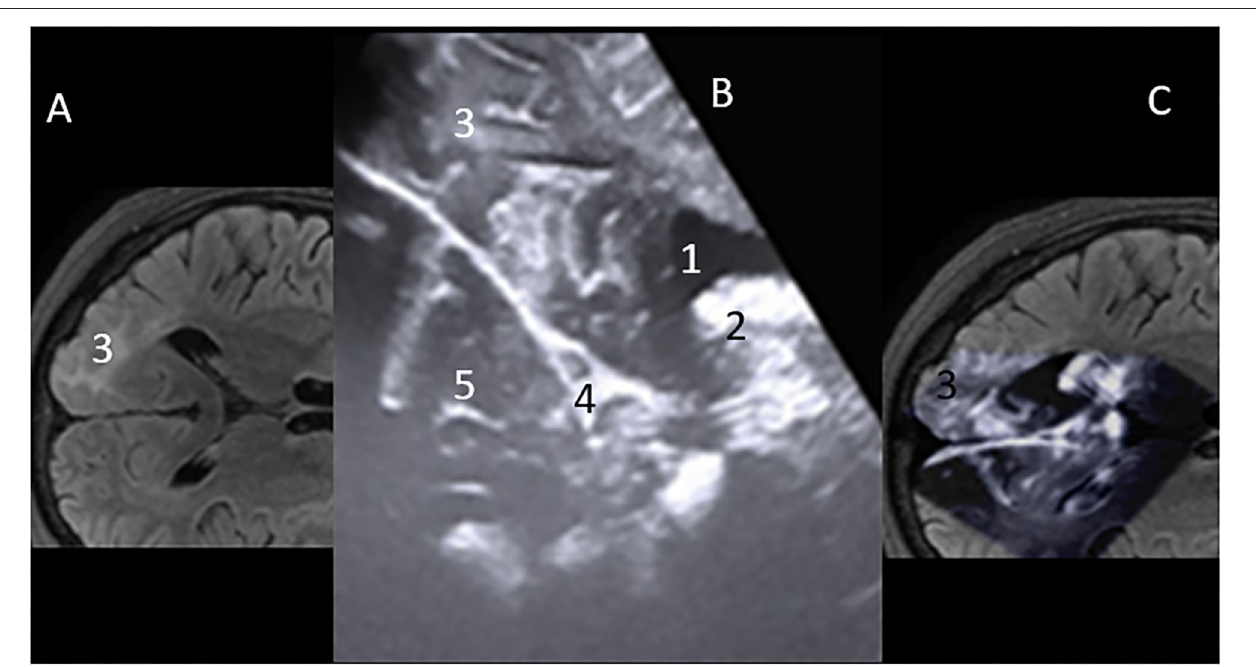
FIGURE 2 | (A) MRI – flair axial view of Rt occipital lobe Focal cortical dysplasia (FCD) lesion-3. (B) Mirror iUS Axial view of Rt occipital lobe FCD lesion-3. Cerebral spinal fluid (CSF) in ventricle occipital horn is “Hypoechoic” on iUS-1; “Hyperechoic” futures vascular stuctures, high grade tumors. Here, the choroid plexis is hyperechoic-2. Falx- 4. Normal brain tissue on iUS is “isoechoic”-5. (C) Projection on the intraoperative Ultrasound Concordance of lesion location on MRI and iUS.